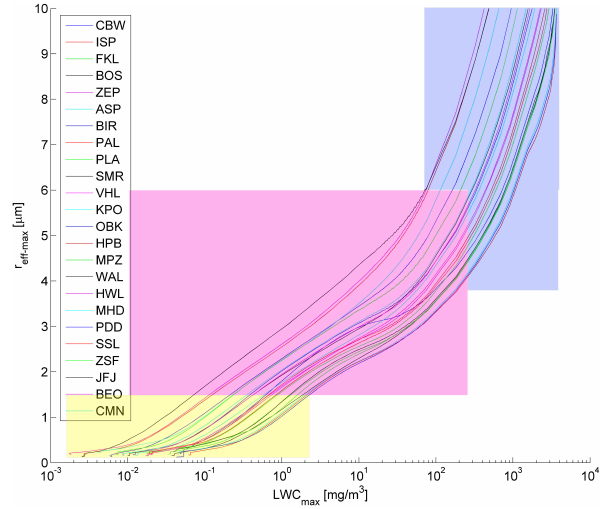
Figure 6. The maximal effective radius ( r eff − max ) vs. the maxi- mal liquid water content (LWC max ) in the cloud for different dry aerosol size distributions (Asmi et al., 2011) and different initial relative humidity perturbations. Each line represents a different dry aerosol size distribution. The labels follow the names given by Asmi et al. (2011). The different shaded regions represent conditions of haze (subsaturation, yellow), transition-zone clouds (magenta), and more developed Cu clouds